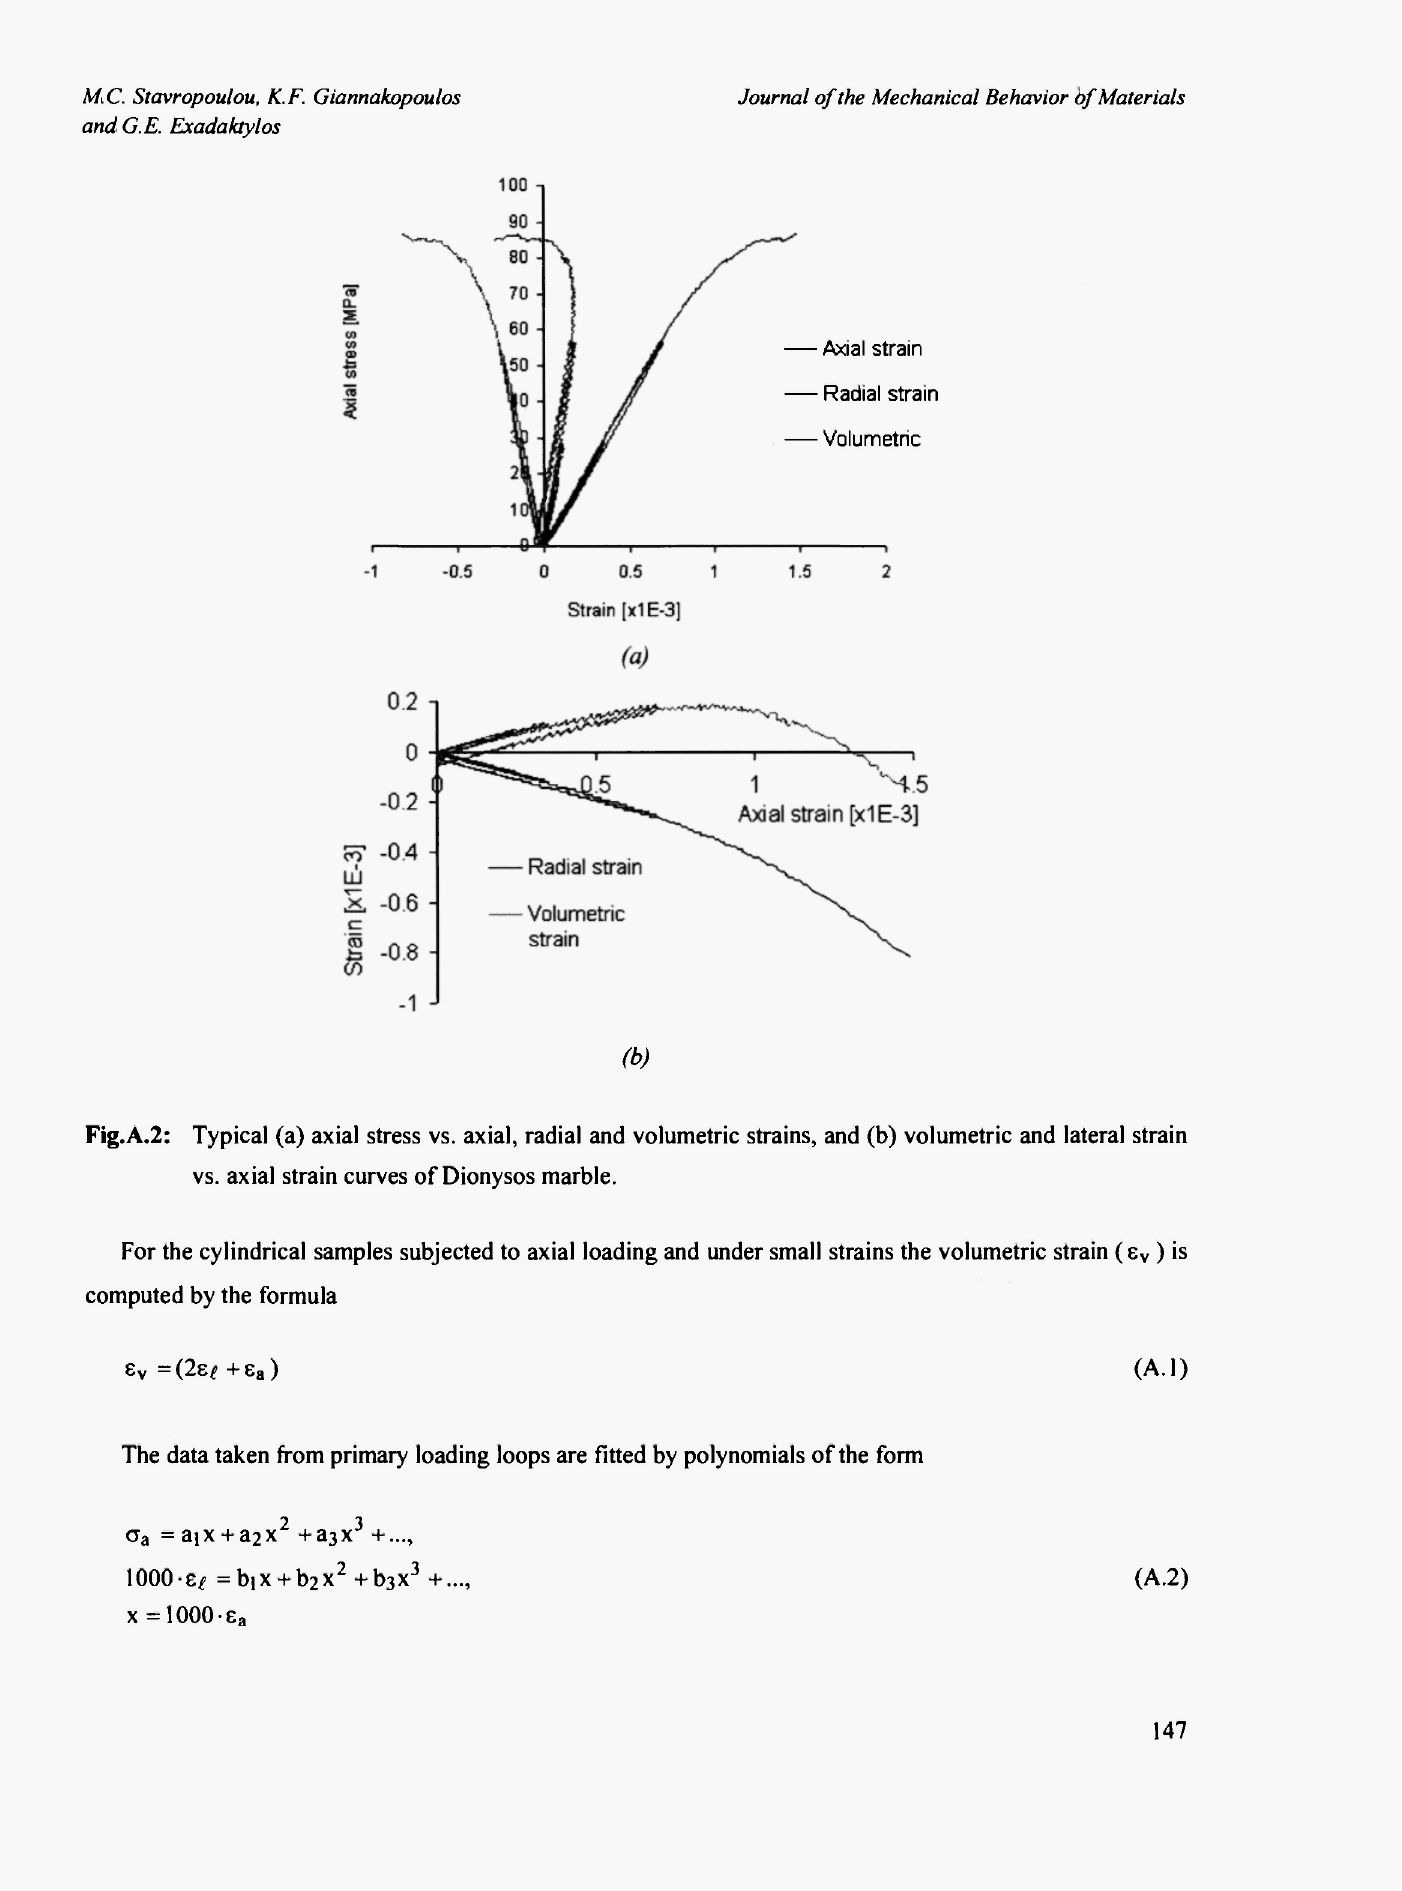
Fig.A.2: Typical (a) axial stress vs. axial, radial and volumetric strains, and (b) volumetric and lateral strain vs. axial strain curves of Dionysos